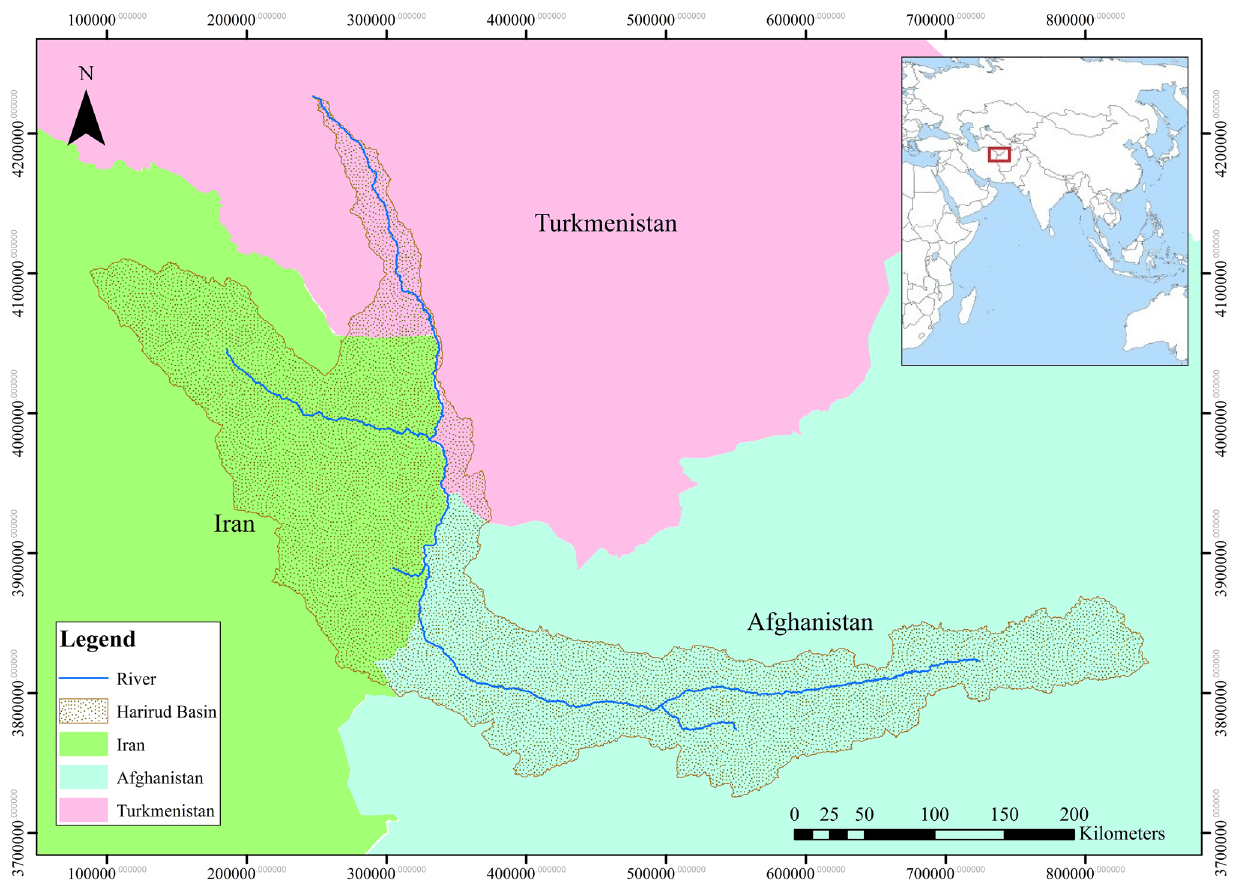
Figure 2. Geographical location of the Harirud river basin (ArcGIS, version: 10.5.0.6491, site: www. esri.